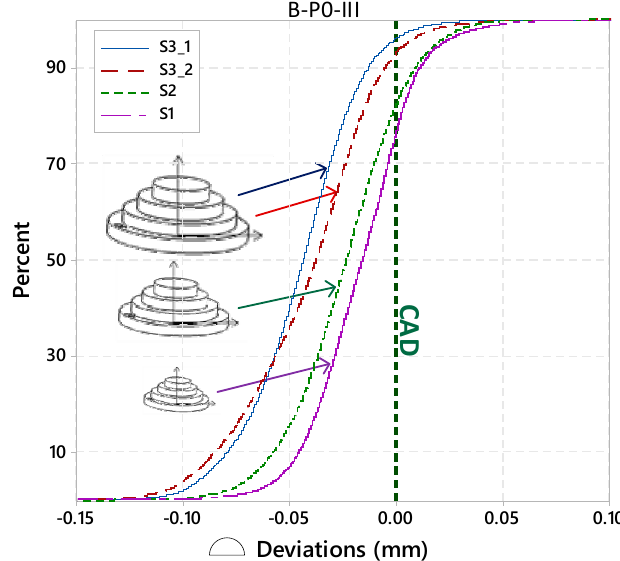
Figure 8. Nonparametric cumulative distribution functions of four Shape B artifacts with no pockets (P0), carried out after part removal .